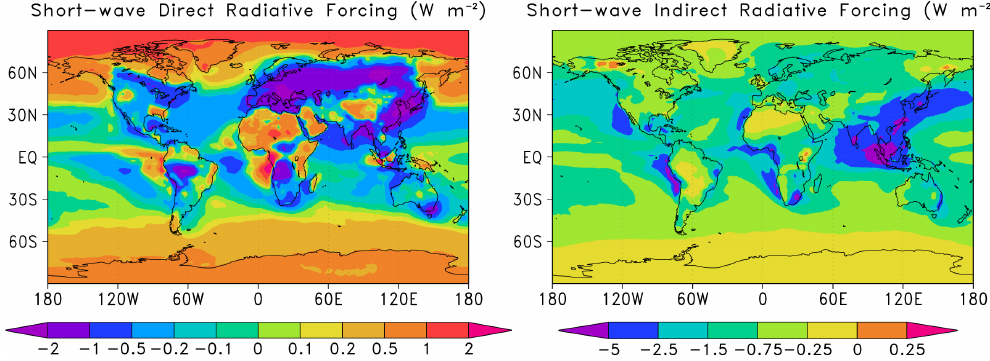
Fig. 11. Modeled annual direct (left, − 0.08Wm − 2 ) and indirect (right, − 1.20Wm − 2 ) top of the atmosphere short-wave radiative forcing in the control simulations ( Ctrl , years 3–7).